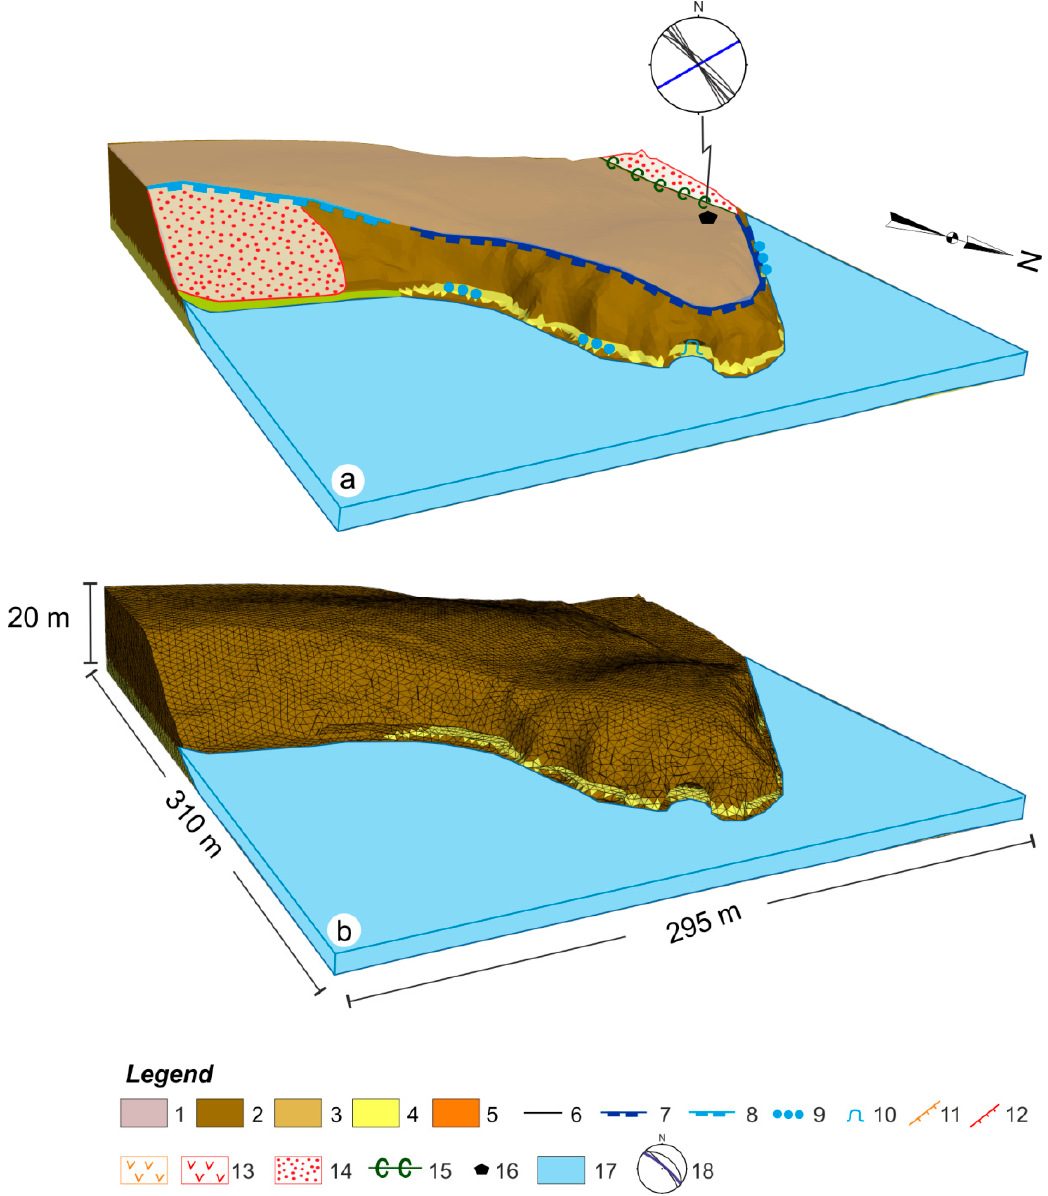
Figure 15. ( a ) The geological and geomorphological features of the Punta Aderci cliff; and ( b ) the simplified model for the numerical modelling (removing superficial deposits < 3 m in thickness).